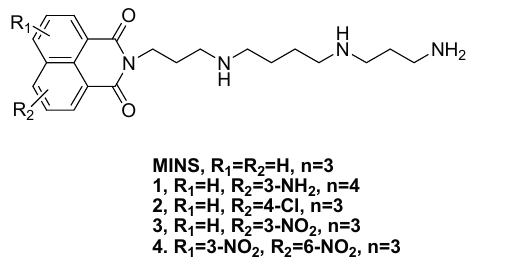
Figure 1. Structures of naphthalimide-polyamine conjugates.